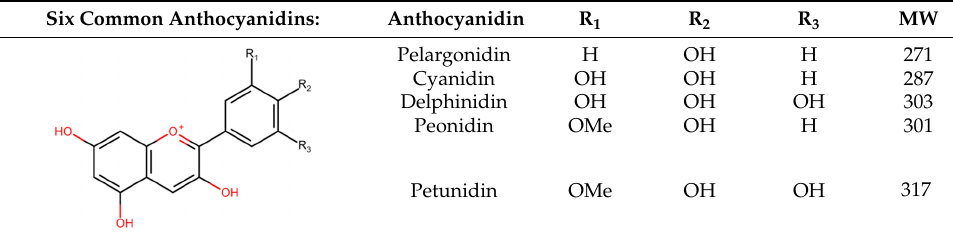
Table 1. Chemical structures and molecular weight of six common anthocyanidins.